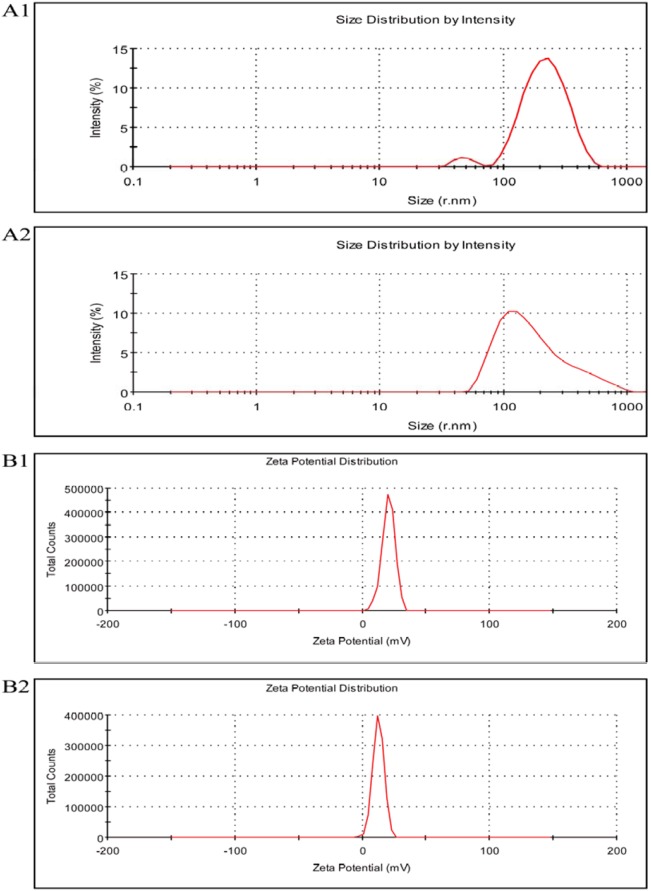
XRD spectrum and Magnetization curve.(A) XRD spectrum of TAT-MPLs. (B) Magnetization curve of Fe3O4 ferrofluid (1) and TAT-MPLs (2).